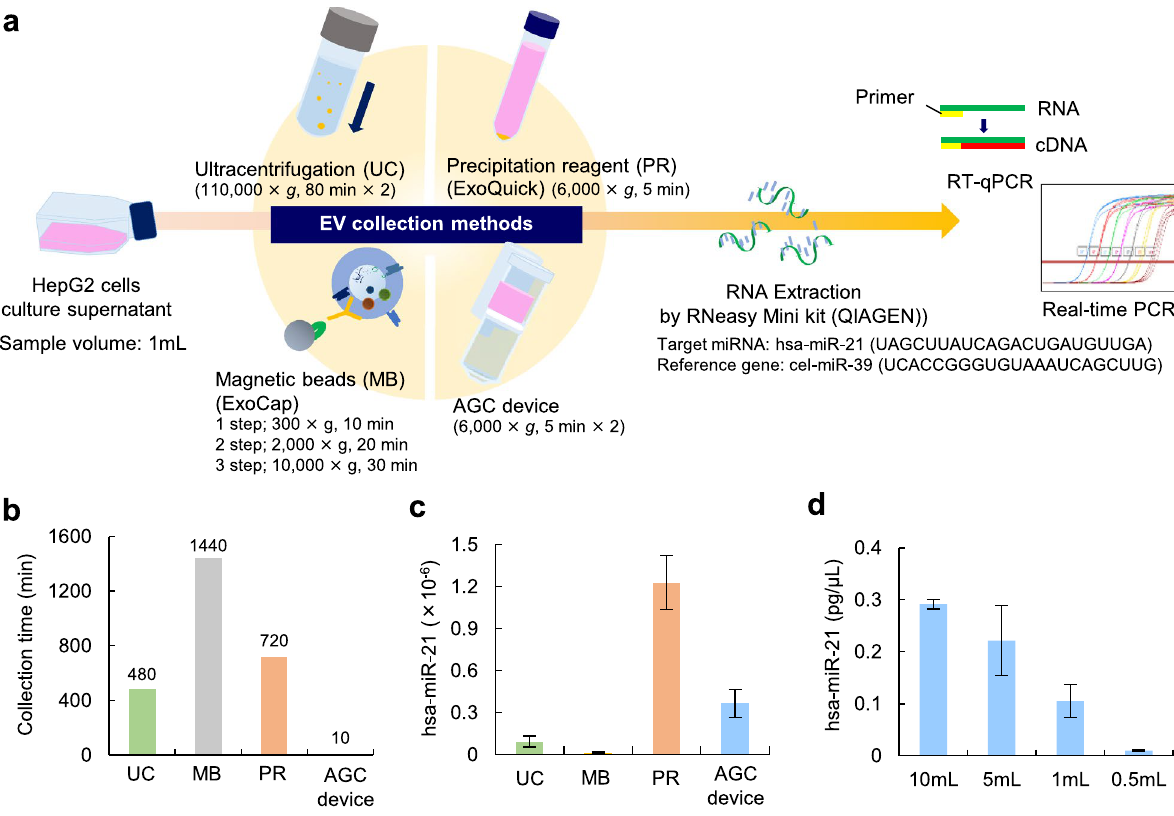
Figure 3. Comparison of four EV collection methods. ( a ) A schematic diagram of the real-time PCR analysis of has-miR-21 extracted from HepG2-EVs collected from cell culture supernatant using four EV collection methods (ultracentrifugation [UC], ExoCap [MB], ExoQuick [PR] and the AGC device). ( b ) The isolation time of HepG2-EVs in UC, MB, PR and the AGC device. ( c ) The detected level of hsa-miR-21 in UC, PR, MB